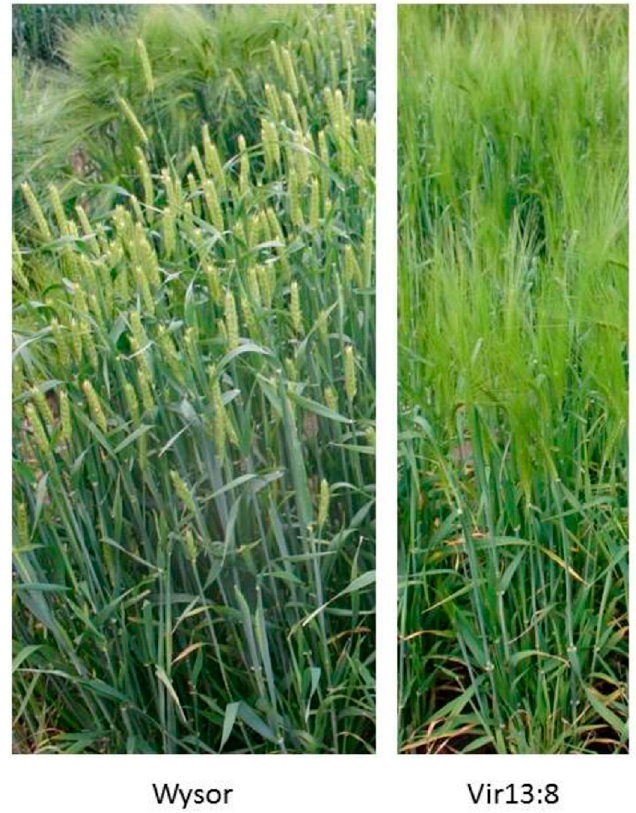
Figure 1. Cultivars used in the present study. Wysor has Ryd2 for moderate resistance to BYDV, whereas line Vir13:8 is a cross between six-rowed, non-malting winter barley cultivar Tramine and the Ryd2 -carrying, two-rowed feed barley cultivar Doria.